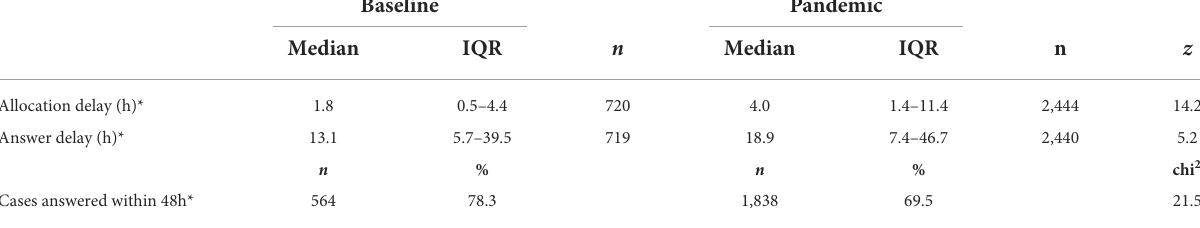
speed of response from specialists was slower during COVID- 19 compared to the baseline. Although the number of FHWs increased during the pandemic, the number of coordinators